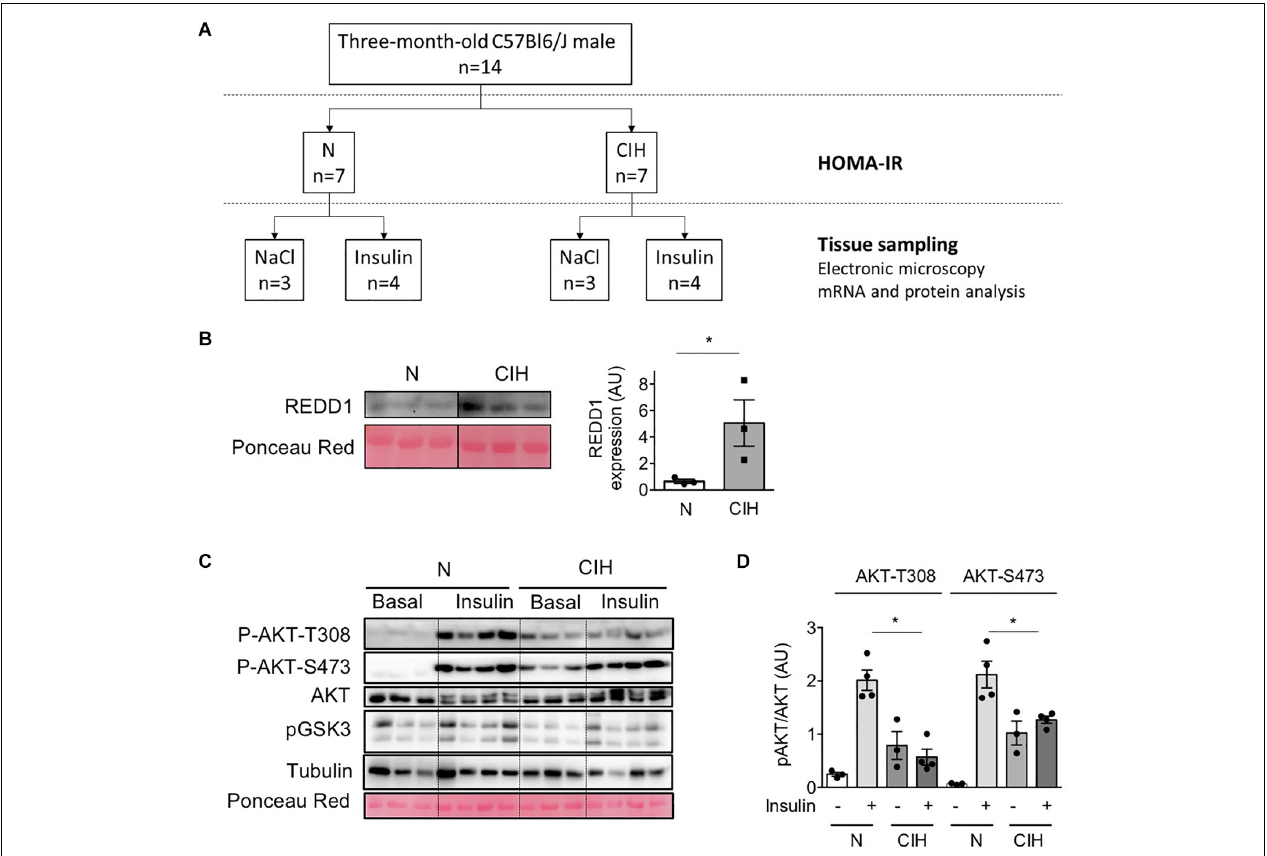
FIGURE 1 | Long-term exposure to CIH, hypoxia-related protein expression and alterations of insulin signaling in adipose tissue. (A) Experimental Design: Fourteen 3-months-old C57Bl6/J male mice were randomly submitted to 6 weeks exposure to chronic intermittent hypoxia (CIH, n = 7) or normoxia (N, n = 7). After 6 weeks CIH and 6 hours fasting, mice were injected with insulin (0.5 U/kg total body weight, i.p, n = 4 per group) or NaCl (100 µ L/10g body weight, i.p, n = 3 per group) and euthanatized 15 min later. (B) Increased REDD1 expression following CIH traduces HIF-1 transactivation. Western Blot of HIF-1 target protein REDD1 was performed in epididymal WAT lysates collected from animals exposed to normoxia (N) or CIH for 6 weeks. The line separates normoxic (N) and epididymal WAT samples from mice exposed to 6 weeks CIH, run on the same blot, but not loaded adjacently. Data are mean ± sem ( n = 3 per group). * p < 0.05 vs. normoxic mice (following Student t -test). (C,D) CIH alters insulin signaling in adipose tissue. AKT phosphorylation (on T-308 and S-473) was investigated in epididymal WAT lysate samples 15 min after NaCl (basal) or insulin injection in 6 h-fasted mice previously exposed to normoxia (N) or CIH for 6 weeks. The phosphorylated-to-total ratios were calculated and is presented for N and CIH (C) . Data are mean ± sem ( n = 3 in basal and 4 in insulin condition, in each group). * p < 0.05 vs. normoxic mice (following one-way ANOVA test, corrected by Tukey’s multiple comparison